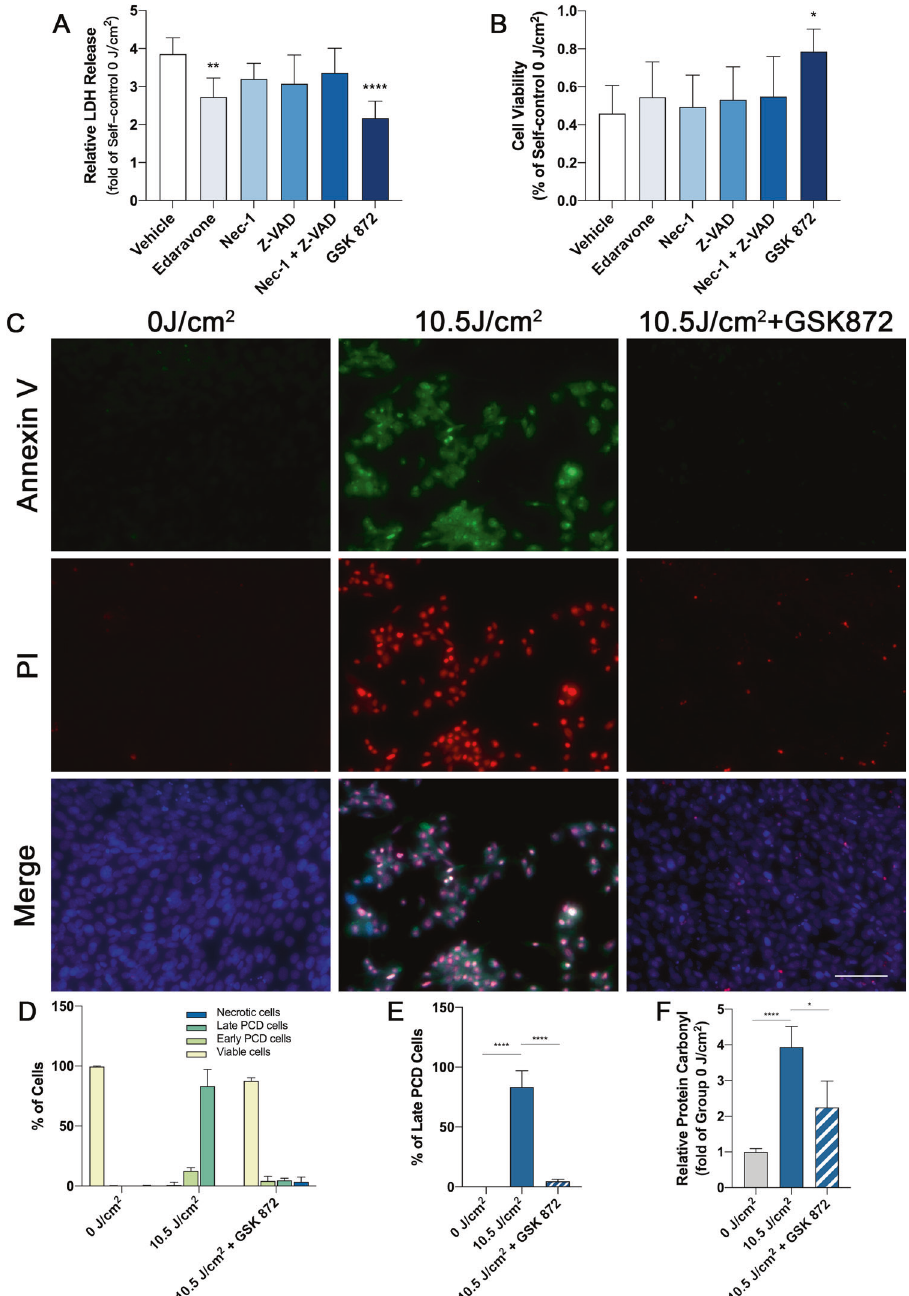
Fig. 4 The inhibition of RIPK3 suppresses cell death and improved cell viability after high-dose UVA irradiation. A LDH release analysis of 661w cells treated with Endaravone (100 μ M), Nec-1 (15 μ M), Z-VAD (15 μ M), combination of Nec-1 (15 μ M) and Z-VAD (15 μ M), GSK 872 (2 μ M) after 10.5 J/cm 2 UVA irradiation ( n = 6 per group). B Cell viability analysis of 661w cells treated with Endaravone (100 μ M), Nec-1 (15 μ M), Z-VAD (15 μ M), combination of Nec-1 (15 μ M) and Z-VAD (15 μ M), GSK 872 (2 μ M) after 10.5 J/cm 2 UVA irradiation by MTT assay ( n = 6 per group). C Representative images of annexin V (green) and PI (red) staining in cells treated with GSK 872 (Scale Bar: 20 μ m) ( n = 6 per group). D Analysis of cell death types in cells treated with GSK 872 ( n = 6 per group). E Analysis of late PCD cells in cells treated with GSK 872 ( n = 6 per group). F ROS production analysis by testing the amount of protein carbonyl in cells treated with GSK 872 after 10.5 J/cm 2 UVA irradiation ( n = 6 per group). Statistical signi fi cance was analyzed with the unpaired Student ’ s t-test. Statistical signi fi cance of compared with 0 J/cm 2 , 3.5 J/cm 2 , 7 J/ cm 2 is indicated as * , # and & . * P , # P or & P < 0.05, ** P , ## P or && P < 0.01, * ** P , ### P or &&& P < 0.001, **** P , #### P or &&&& P < 0.0001. All values are expressed as mean ±